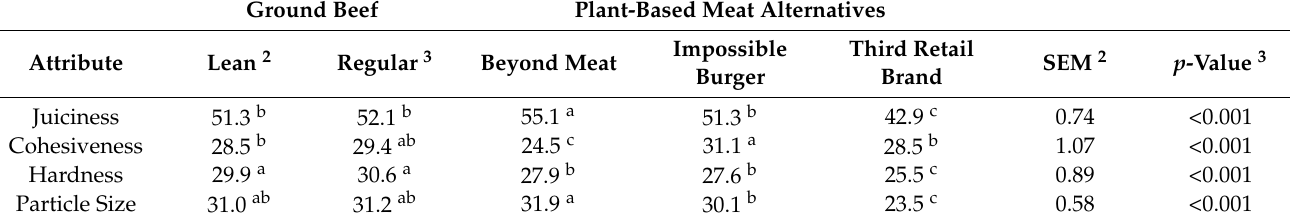
Table 2. Least squares means of descriptive texture attributes 1 from three plant-based meat alterna- tives and two lean levels of ground